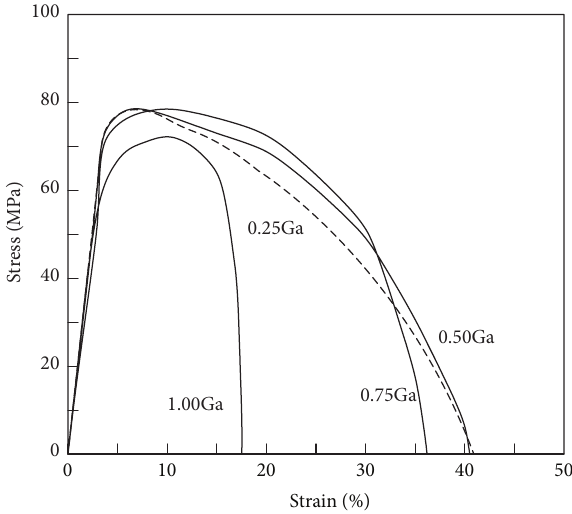
Figure 5: The tensile stress-strain curves of the Sn-9Zn, Sn-9Zn- 0.25Ga, Sn-9Zn-0.50Ga, Sn-9Zn-0.75Ga, and Sn-9Zn-1.00Ga solder alloys.